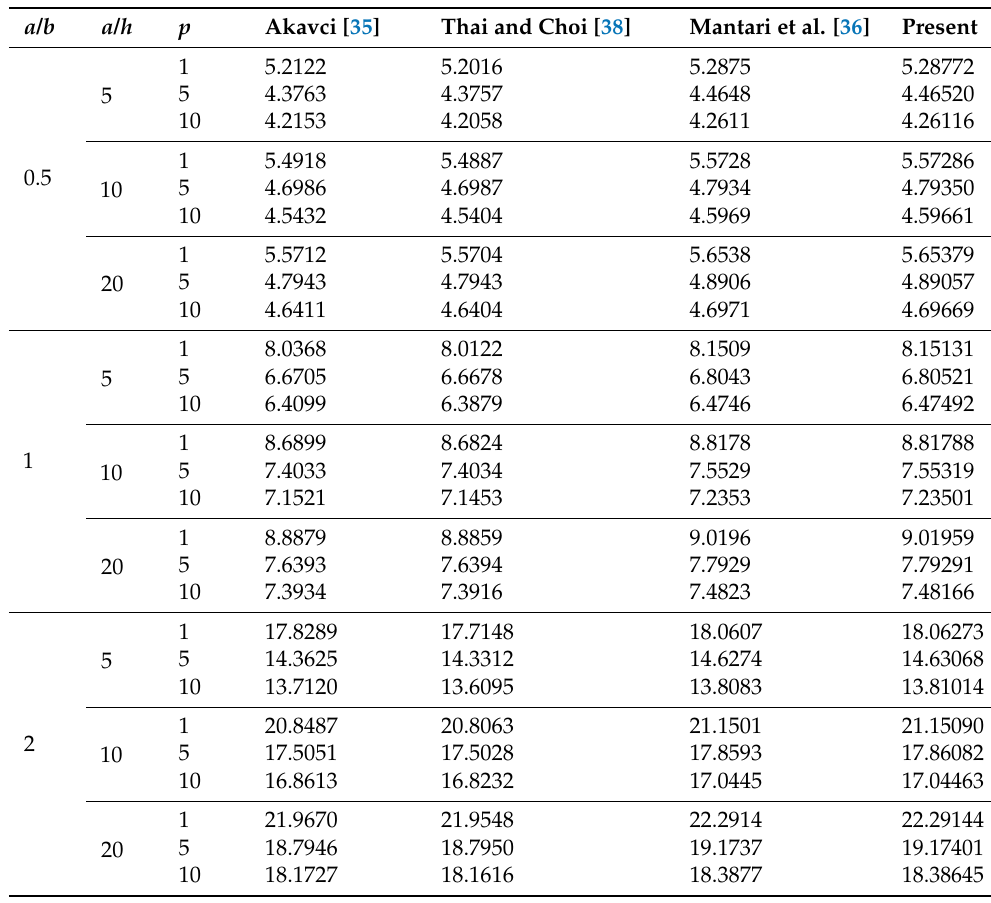
Table 11. Non-dimensional fundamental frequencies ˇ ω = rectangular plates ( k w = k s = c d =